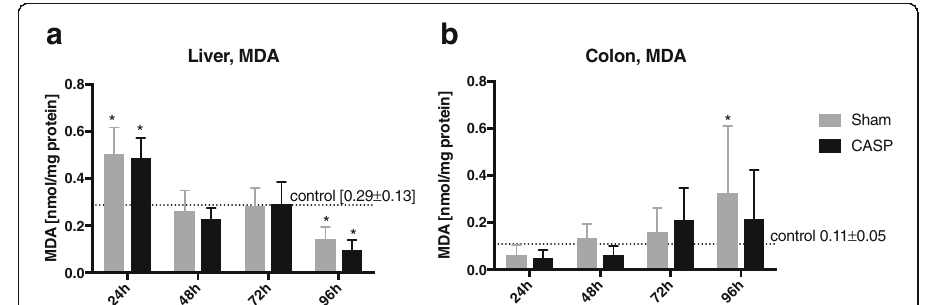
Fig. 4 Assessment of MDA levels in the liver and colon tissue homogenates. MDA levels were detected by condensation with thiobarbituric acid and normalized to protein concentration in the liver ( a ) and colon ( b ) tissue homogenates. Data are shown as mean ± SD, * p < 0.05 vs. healthy controls, between groups (control n = 9, sham n = 12, CASP n = 11 –